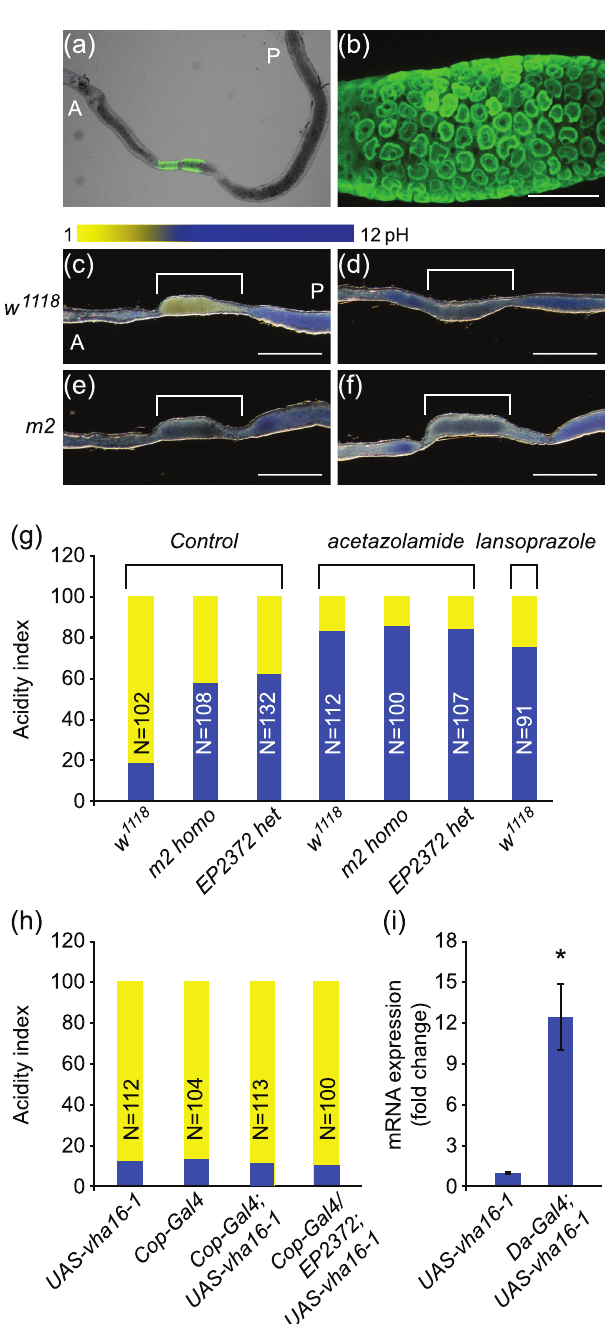
Fig 2. vha16-1 mutation reduces gut acidity in flies. (a and b) m2 > UAS-GFP reporter flies showing that vha16-1 was highly expressed in the Drosophila midgut region. Scale bars = 100 μ m. (c-f) Representative images showing that m2 homozygous mutant flies (e) displayed reduced midgut acidity compared to control flies (c, w 1118 ). The midgut acidity can also be diminished by feeding both control flies (d) and m2 homozygous mutant flies (f) with carbonic anhydrase inhibitor (acetazolamide). Scale bars = 0.5 mm. The anterior and posterior regions of Drosophila midgut are marked as “ A ” and “ P ” , respectively. (g) Quantitative results showing that majority of m2 homozygous, EP2372 heterozygous mutant flies, and acetazolamide- or lansoprazole-treated flies had diminished midgut acidity compared to control flies. (h) vha16-1 overexpression specifically in copper cells ( Cop-Gal4/;UAS-vha16-1 ) did not affect the midgut acidity of flies, but did recover the midgut acidity of EP2372 heterozygous mutant flies to normal level. (i) Effectiveness of the UAS-vha16-1 constructs used for vha16-1 overexpression was verified by crossing daughterless